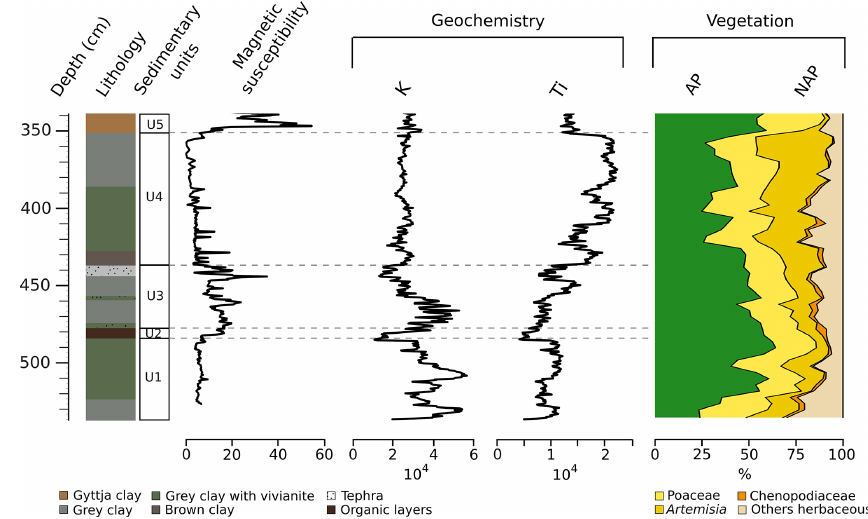
Figure 2. Sediment lithology, magnetic susceptibility, geochemical data and selected terrestrial pollen taxa at Matese. Arboreal pollen (AP; green) and non-arboreal pollen (NAP; yellow and orange) are expressed in percentages of total terrestrial